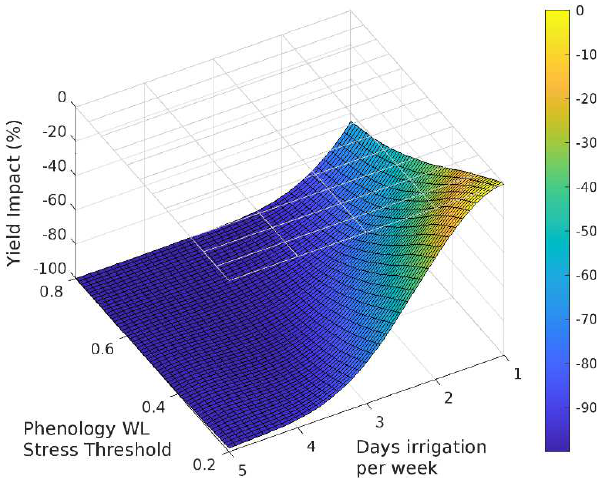
Figure 4. Sensitivity of the response function associated with phenology on grain yield.